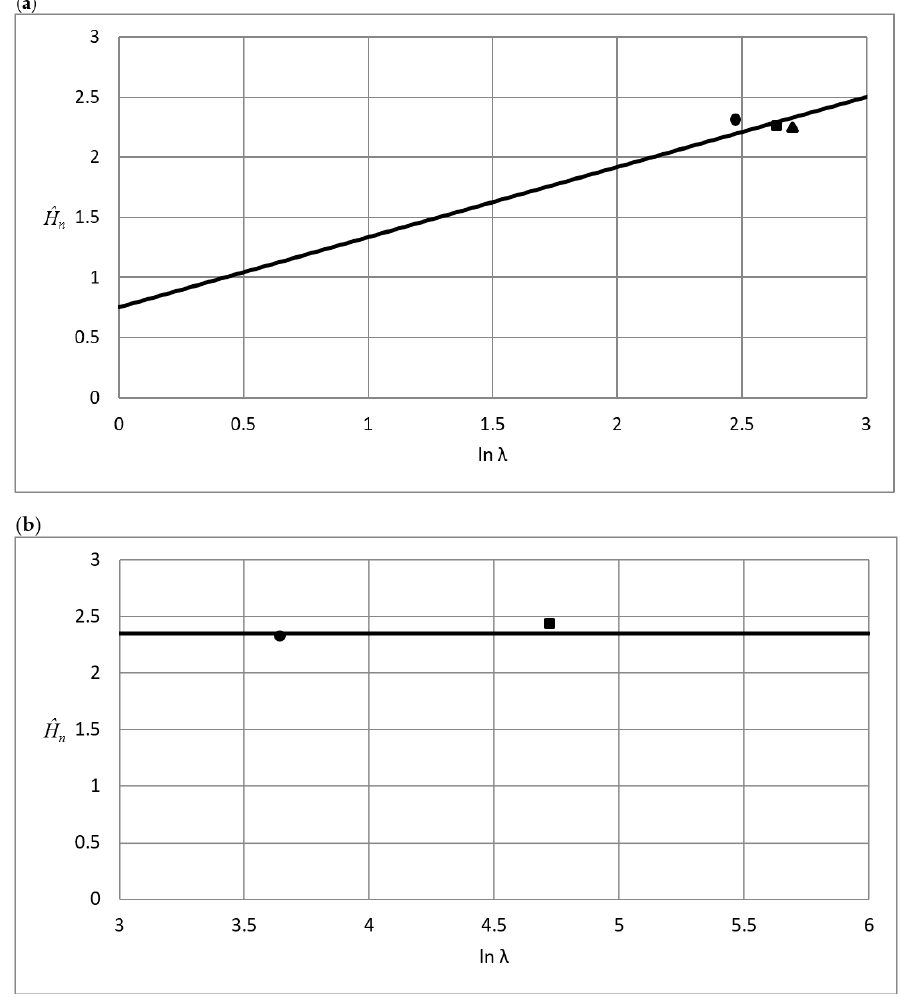
Figure 5. Normalized normal scratch hardness, Ĥ n = H n / σ rep , as function of ln Λ where Λ is the Johnson parameter defined in Equation (1). Results taken from Wredenberg and Larsson [20]. ( a ) The representative stress was determined from σ rep = σ ( ε p = 0.25). The thick line represents upper Equation (8). ( ● ), experimental results for PMMA as detailed in Table 1. ( ■ ), experimental results for epoxy as detailed in Table 1. ( ▲ ), experimental results for vinyl ester as detailed in Table 1. ( b ) The representative stress was determined from σ rep = σ ( ε p = 0.39). The thick line represents lower Equation (8). ( ● ), experimental results for Al7050 as detailed in Table 1. ( ■ ), experimental results for stainless steel as detailed in Table 1.